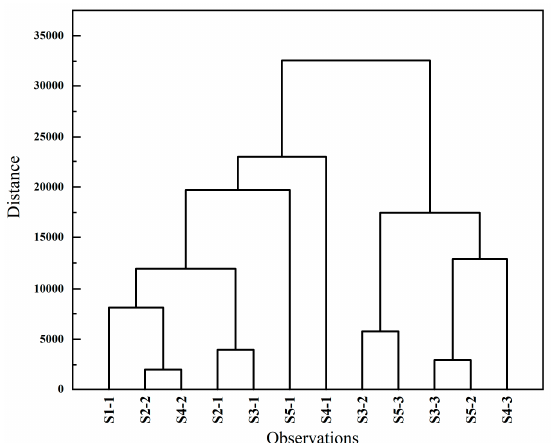
Figure 5. Cluster analysis on Phaeocystis globosa and Nitzschia closterium of JSB during spring algal bloom period.